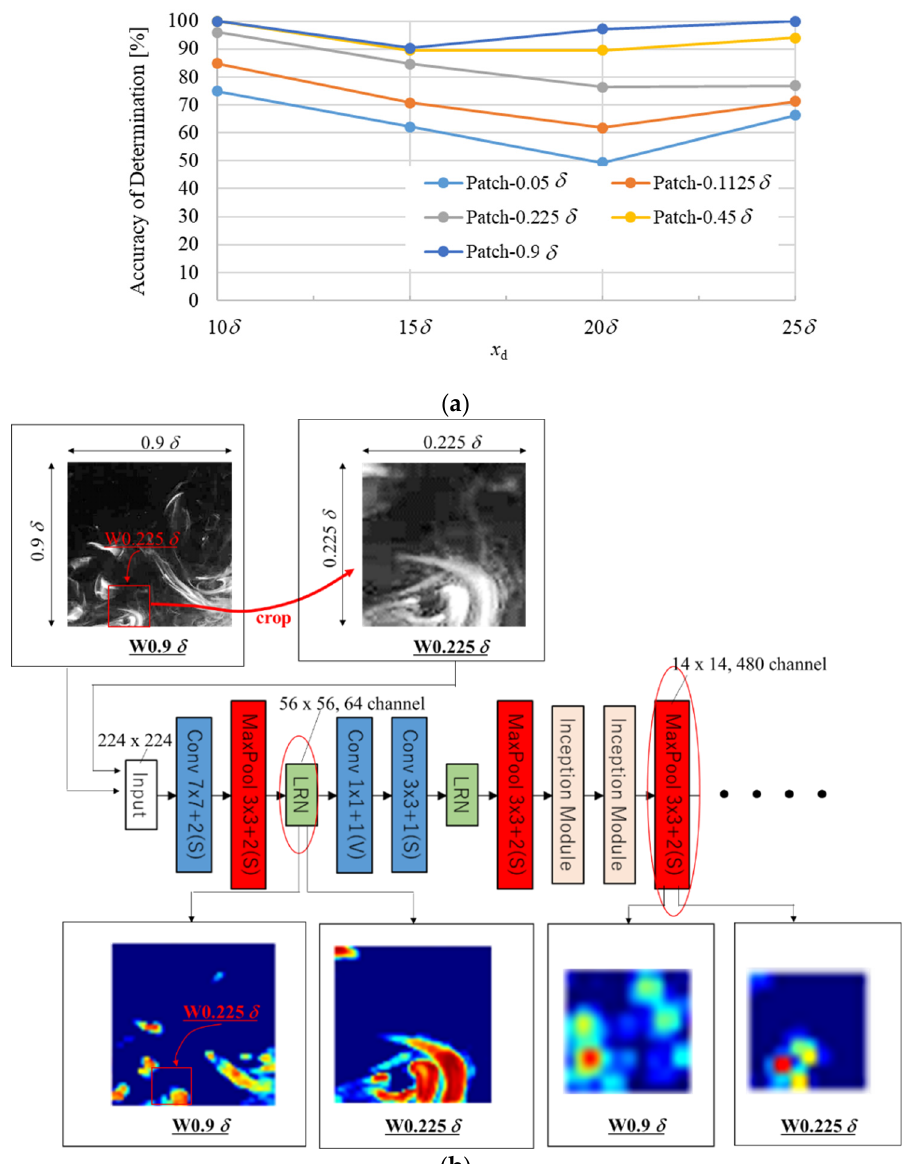
Figure 5. ( a ) Accuracy of determination for each patch size. ( b ) Sample images for a feature map of first LRN and third max pool in W0.9 δ and W0.225 δ .